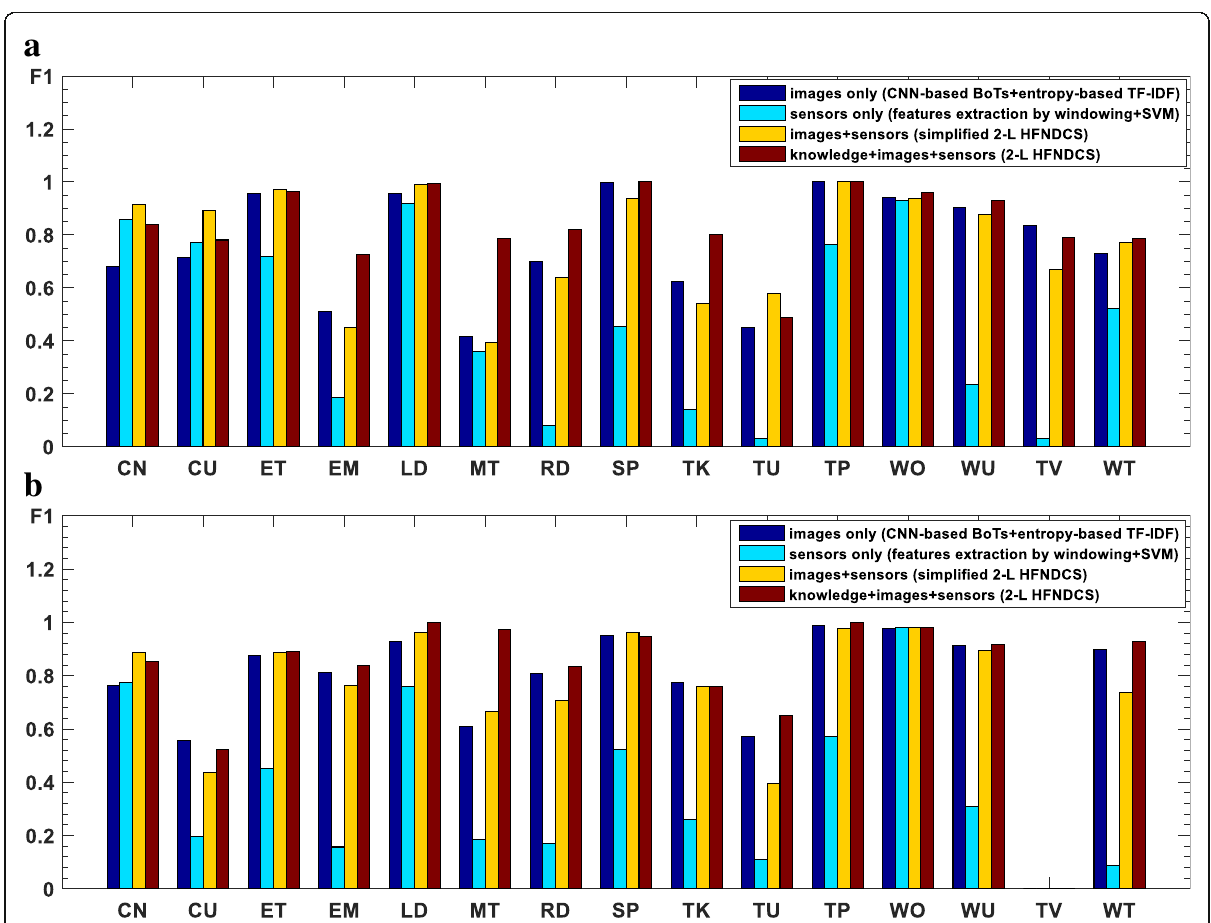
Fig. 10 F 1 measures of four methods as bar graphs for a wearer 1 and b wearer